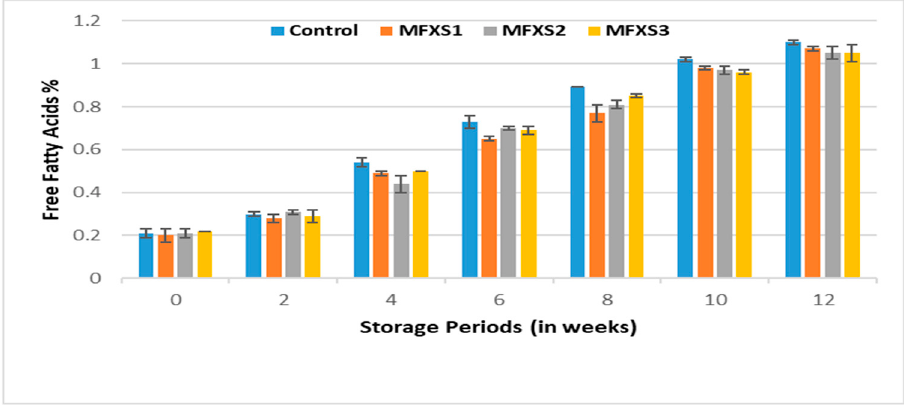
Figure 4. The free fatty acid of mayonnaise samples during cold storage (7 ± 2 °C). Control sample: 70% soy bean oil, MFXS1: 20% flaxseed oil and 50% soy bean oil, MFXS2: 30% flaxseed oil and 40% soy bean oil, and MFXS3: 40% flaxseed oil and 30% soy bean oil.